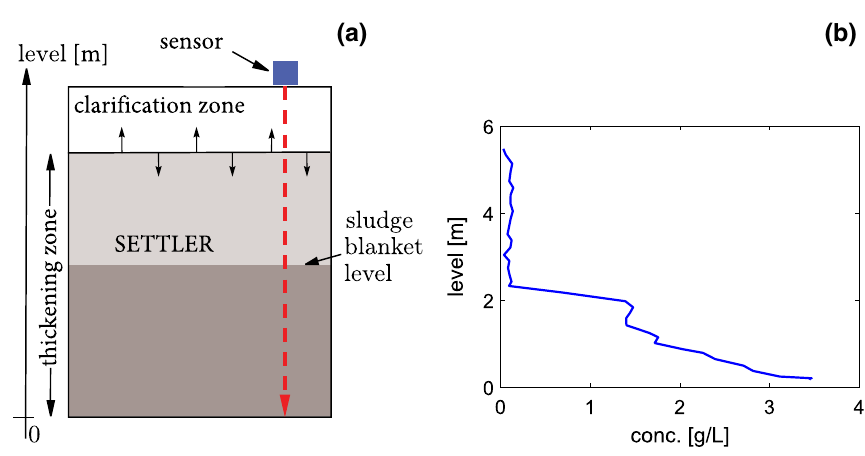
Fig. 1 a Experiment setup; b typical sludge profile plotted as level versus SS